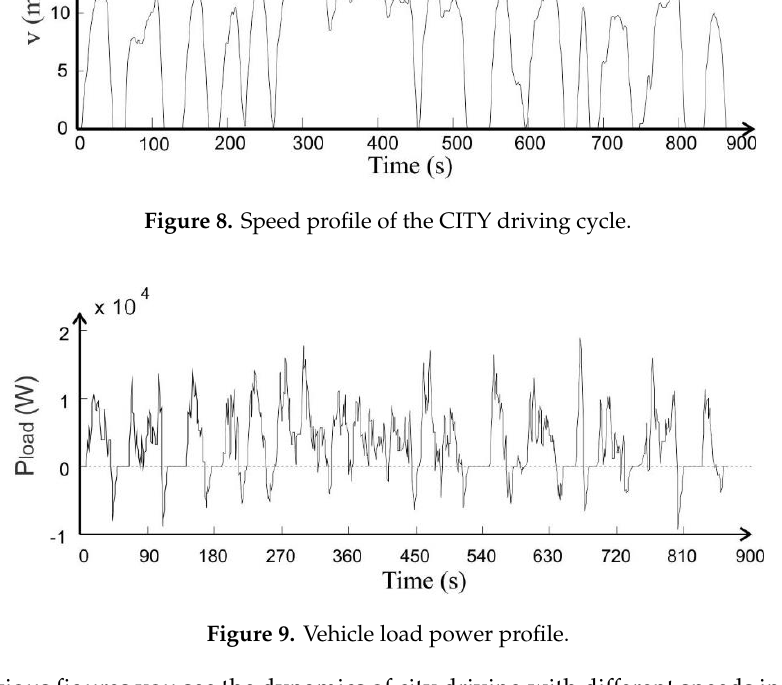
Figure 10. Battery pack power. Figure 11. UC bank power. The power delivered by the Bs and the UCs is defined by the EMS, taking into account the parameters of Tables 1 and 2. This power distribution between the Bs and the UCs satisfies the load demand in order to operate the vehicle at the speeds given by the CITY cycle. The charge states of the B pack and the UC bank are shown in Figures 12 and 13.